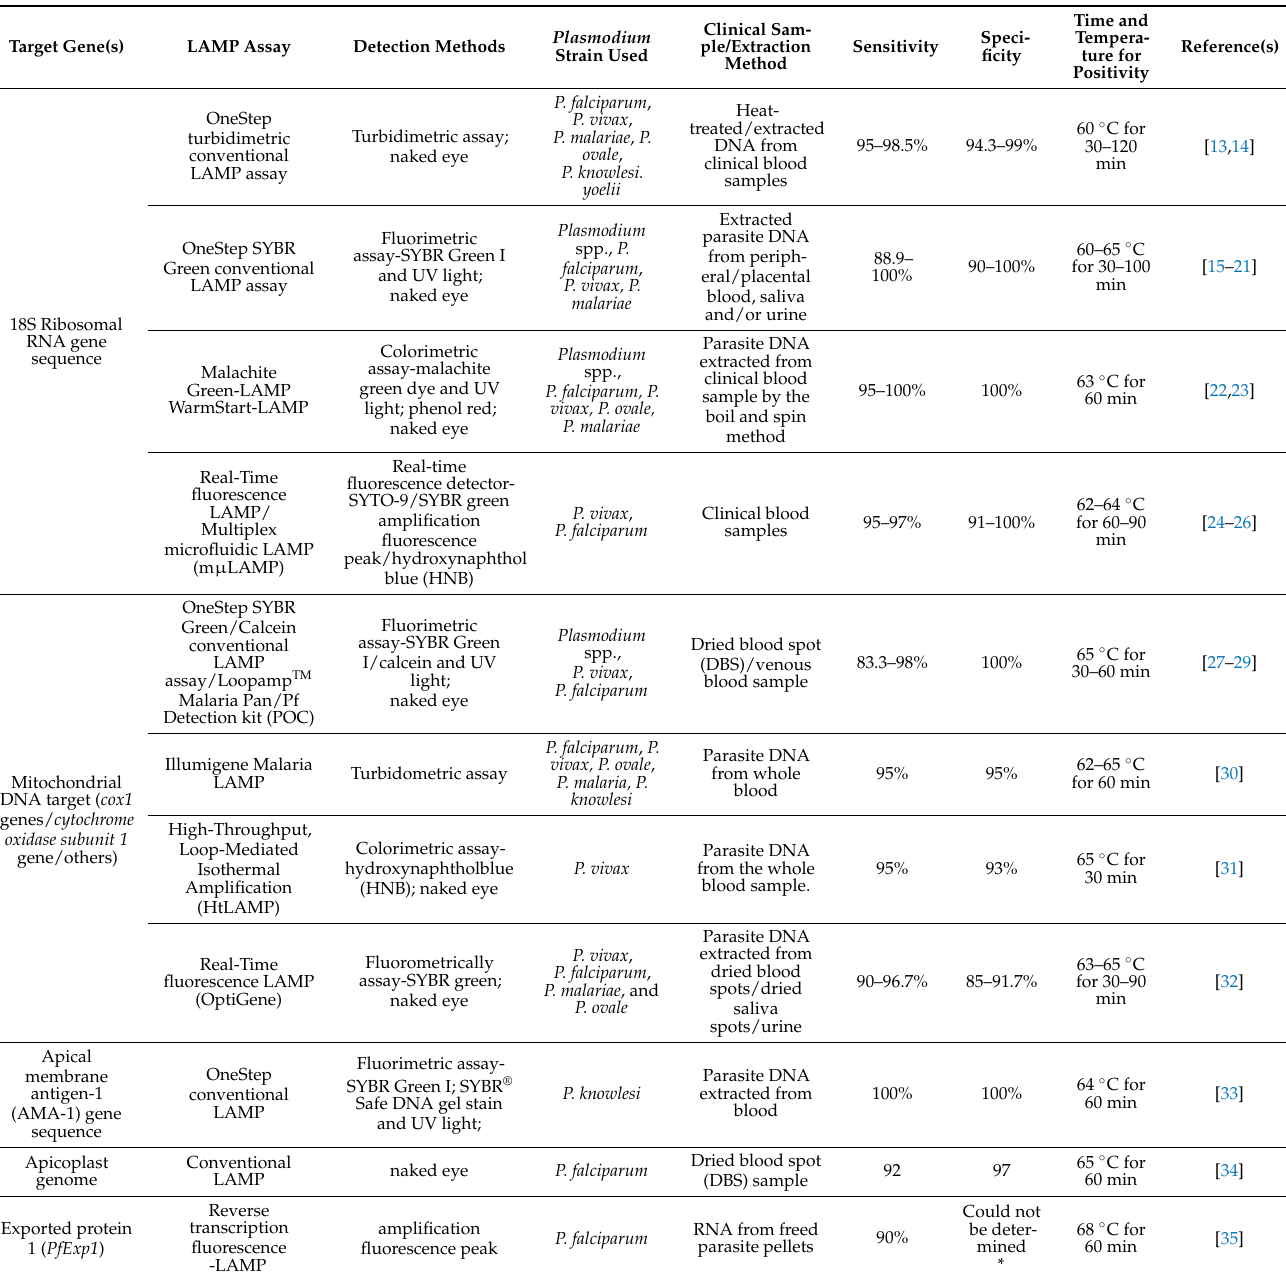
Table 1. Detailed information of different targets, detection methods and diagnostic accuracy for LAMP assays developed for the diagnosis of